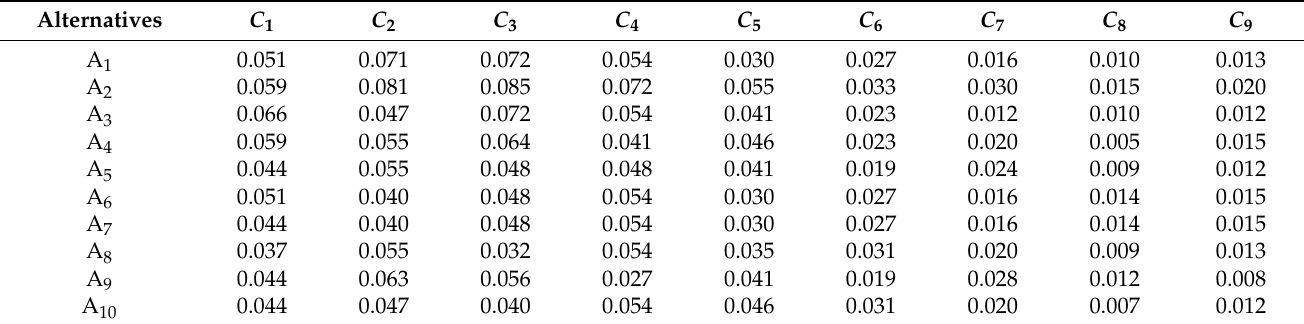
Table 7. Weighted normalized